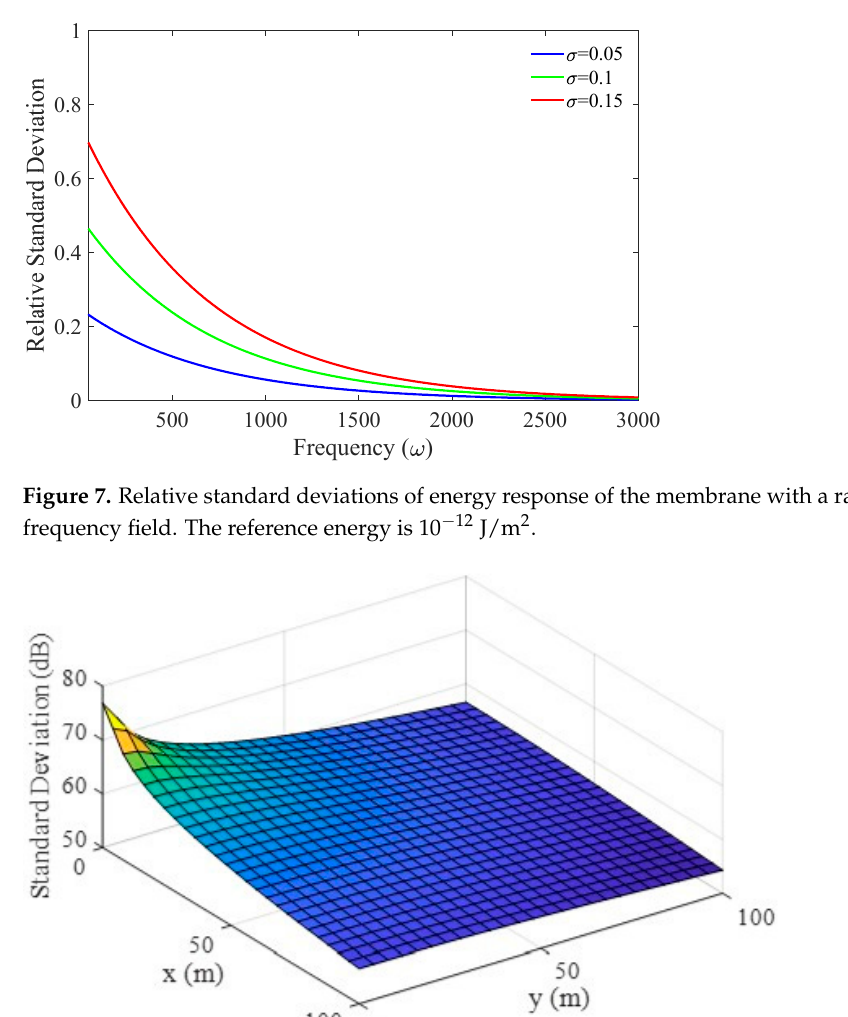
Figure 6. Energy response intervals of the membrane with a random length in frequency field. The reference energy is 10 − 12 J/m 2 .